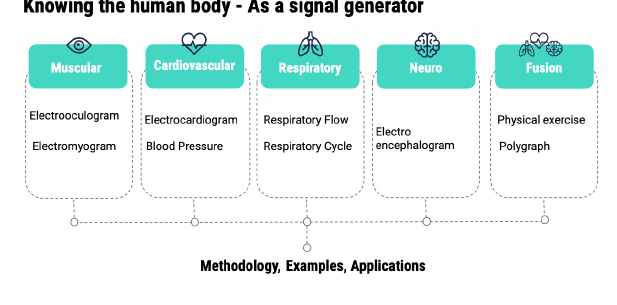
Figure 3. Thematic modules for theoretical and practical classes (Biological Engineering Workshop